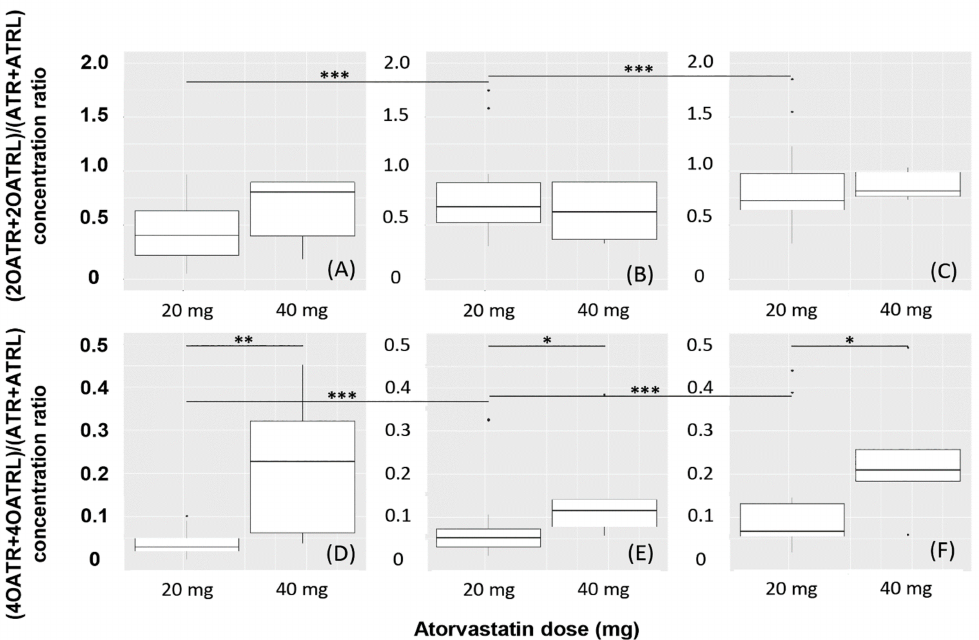
Figure 5. Metabolite/parent drug (acid + lactone form) concentration ratios obtained at 2, 4 and 6 h post dose in human subjects receiving their first 20-mg or 40-mg dose of atorvastatin (n = 29). (2OATR + 2OATRL)/(ATR + ATRL) concentration ratios are displayed at ( A ) 2 h, ( B ) 4 h, and ( C ) 6 h, and (4OATR + 4OATRL)/(ATR + ATRL) concentration ratios at ( D ) 2 h, ( E ) 4 h, and ( F ) 6 h. Asterisks indicate the significance of differences: p < 0.05 (*), p < 0.01 (**), or p < 0.001